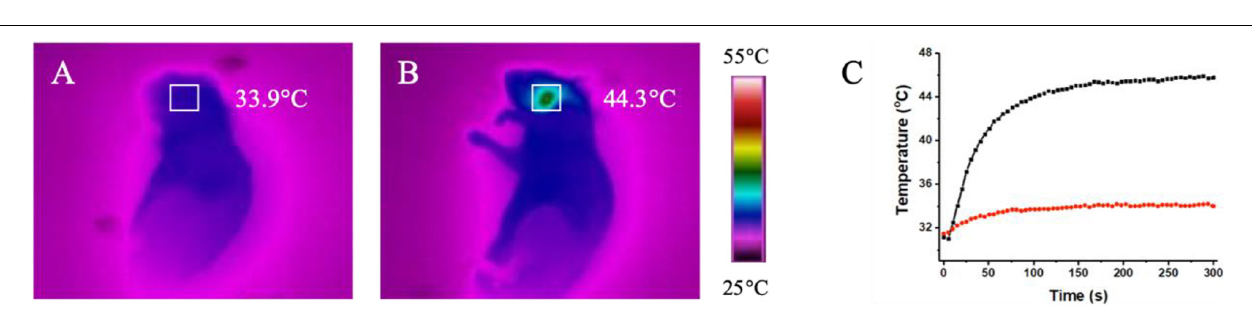
significant difference on cell cytotoxicity was identified between the CuBiS 2 NPs group and the control group below the concentration of 160 mg/mL, while significant cytotoxicity was observed when macrophages were co-incubated with CuBiS 2 NPs at concentration above 160 mg/mL, indicating that CuBiS 2 NPs exhibited good biocompatibility at concentration of 160 mg/mL ( Figure 3B